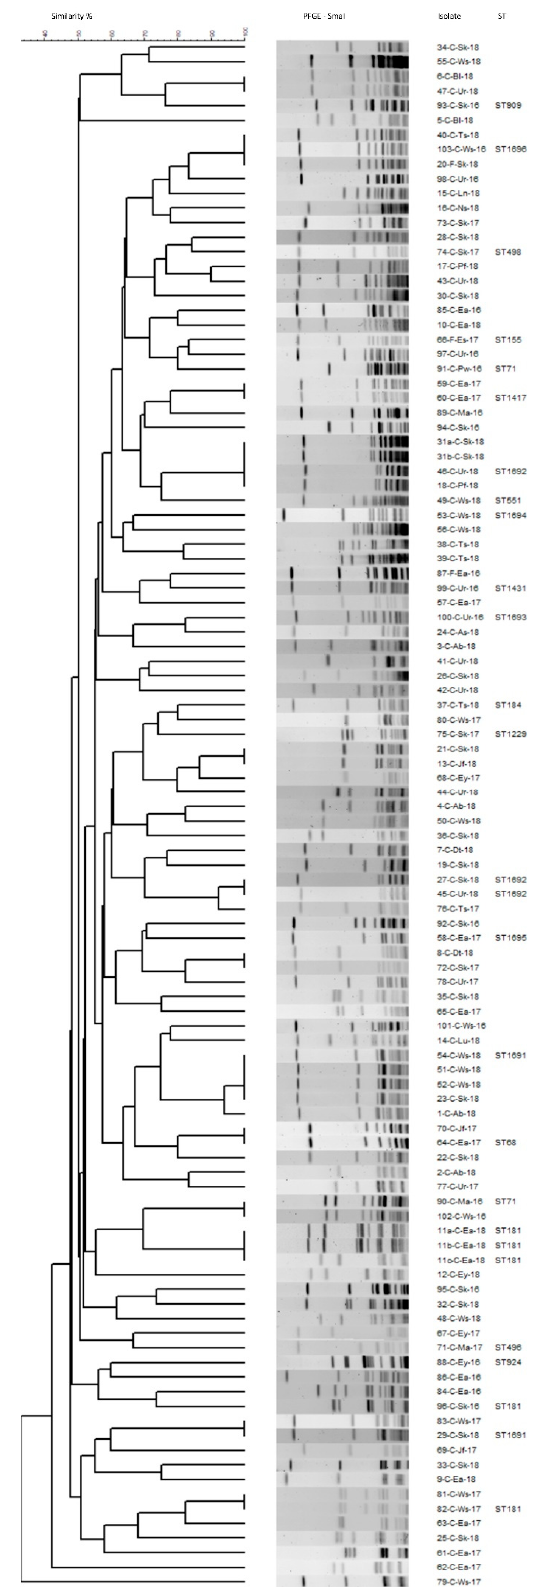
Figure 3. PFGE dendrogram of representative ( n = 106) methicillin-resistant S. pseudintermedius (MRSP) isolates from this study. MLST-based sequence types (STs) are also shown on the far-right column when available. Isolate prefixes (from left to right): numerals, isolate numbers; C,